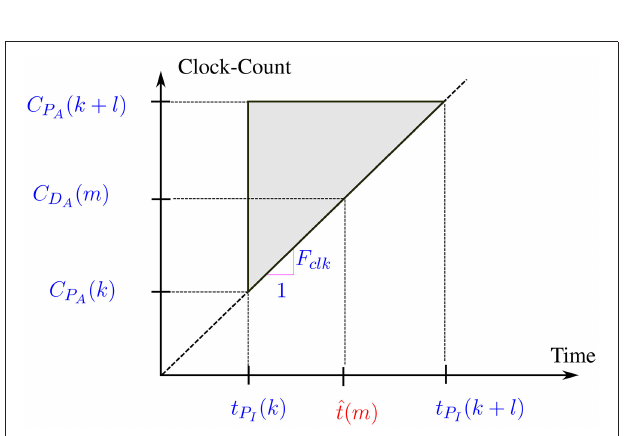
FIGURE 5 | Proposed timestamping